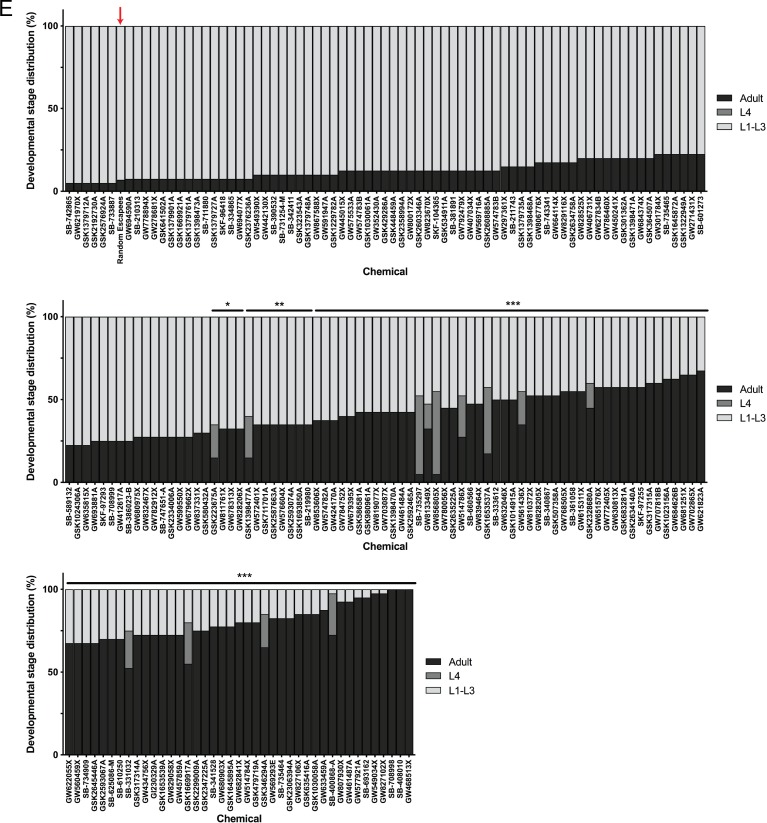
Post-hoc statistical analysis showing that 142 chemicals out of the 278 chemicals identified from the primary screen produced developmental stage distributions that were significantly different from random escapee wells (red arrows).It is important to note that this was performed with the assumption that 20 worms were in each well as a means of estimating the proportion of actual L4 and adult counts in each well. In other words, we assumed #L1-L3 larvae = 20 – (#L4 + #adult). Plots shown are from independent screens of (E) 60 μM GlaxoSmithKline Published Kinase Inhibitor set. Statistical analysis by Kruskal-Wallis test with Dunn’s multiple comparisons post-test where *p<0.05, **p<0.01, ***p<0.001.